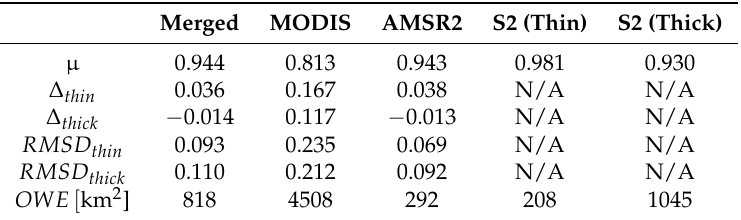
Table 2. Comparison of the different SIC datasets in Figure 9. We show the mean µ , the mean difference ∆ between the thin- and thick-ice Sentinel-2 SIC and the respective dataset and the RMSD with regard to the thin- and thick-ice Sentinel-2 SIC and the open water extent (area of pixels with less than 85% SIC). A positive difference means that the Sentinel-2 SIC is higher. All quantities except the open water extent are given as fraction of 1. Only pixels where all datasets are available are considered for the comparison. For this scene, this amounts to 8191 of 11,881 pixels, equivalent to an area of 8191km 2 . Details about location and acquisition time of the scene are given in the caption of Figure 9. Merged MODIS AMSR2 S2 (Thin) S2